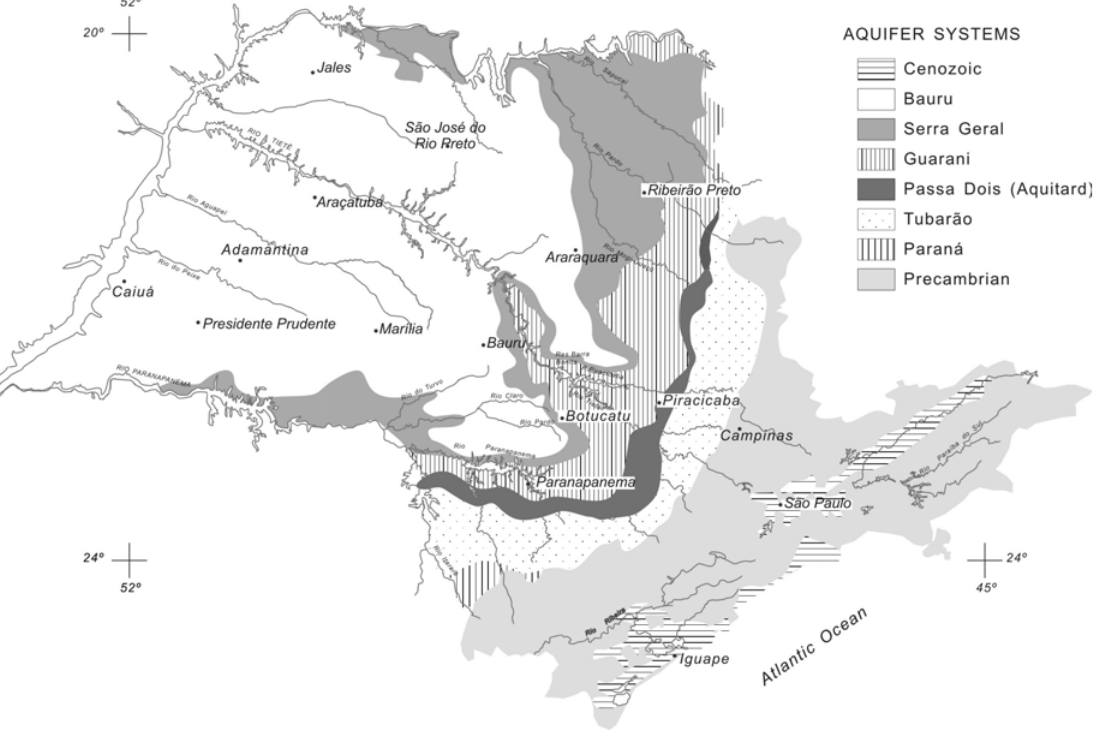
Fig. 1 – Main aquifer systems in the state of São Paulo.